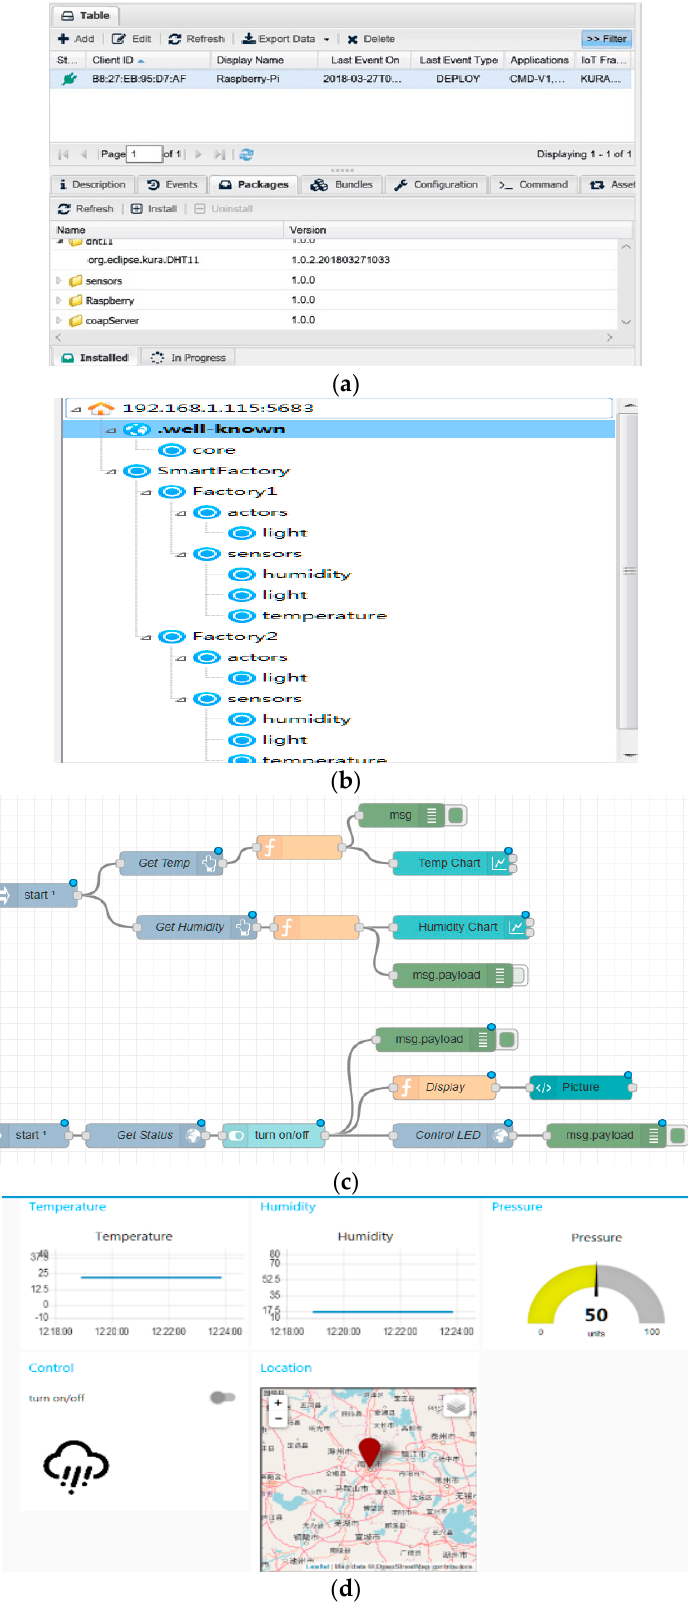
Figure 6. IoT application platform based on open source ecosystem: ( a ) gateway management and data collection; ( b ) CoAP resource discovery; ( c ) Node-Red development; and ( d ) Dashboard GUI.